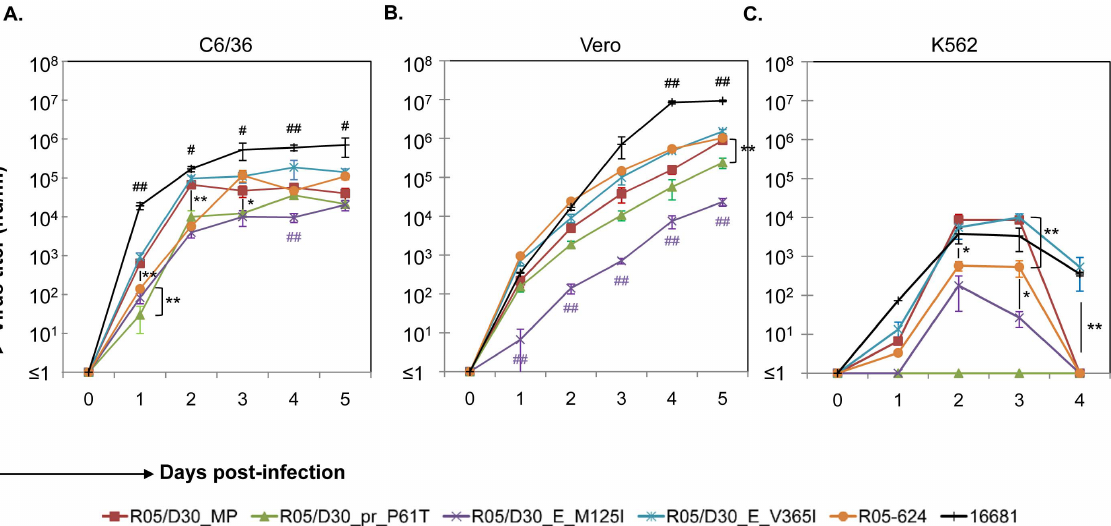
Figure 4. Replication kinetics of recombinant DENVs. DENV-2 16681 or individual recombinant DENVs were used to infect C6/36 (A) and Vero cells (B) at an MOI of 0.001, or K562 cells (C) at an MOI of 0.1. After 2 hours of incubation, the supernatants were removed and cells were washed twice with plain medium before the addition of maintenance medium supplemented with 2% FBS. For infected C6/36 and Vero cells, the supernatants were harvested daily. For infected K562 cells, both the culture medium and infected cells were harvested and centrifuged. Virus titers in the supernatants were determined in focus-forming assays in Vero cells. Results are expressed as mean 6 SD of triplicate experiment (* p , 0.05 and ** p , 0.01 , unpaired two-tailed Student’s t-test, n=3 per point). Statistically significant differences between data points are indicated by # ( # p , 0.05 , ## p , 0.01 ).